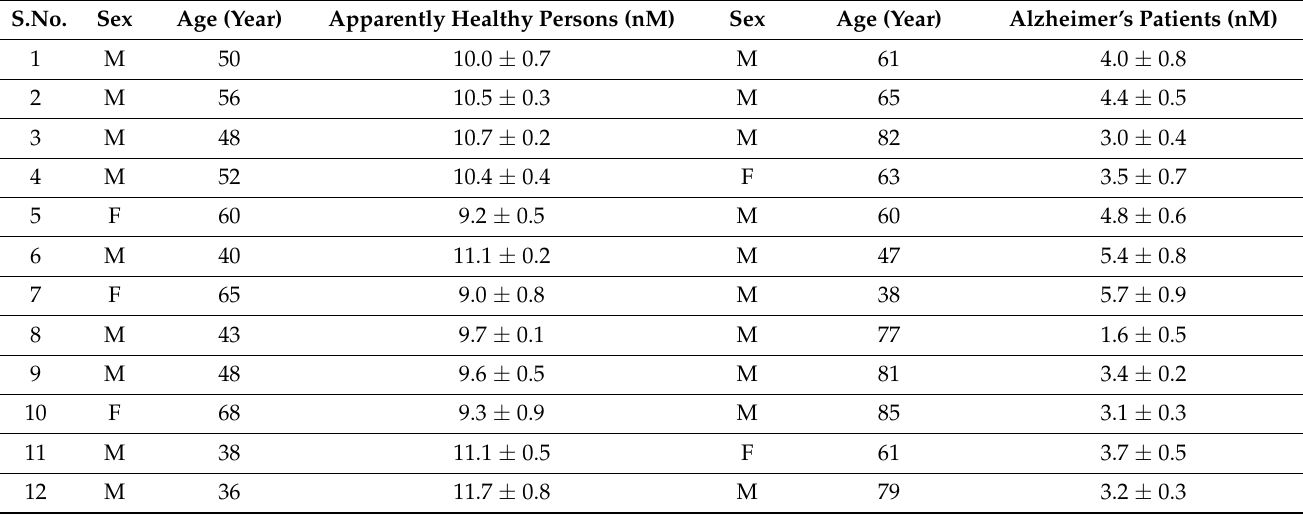
Table 1. Acetylcholine levels in serum of Alzheimer’s patients and apparently healthy individuals, as determined by biosensor based on AChENPs/ChONPs/GONS/PtNPs/PGE.